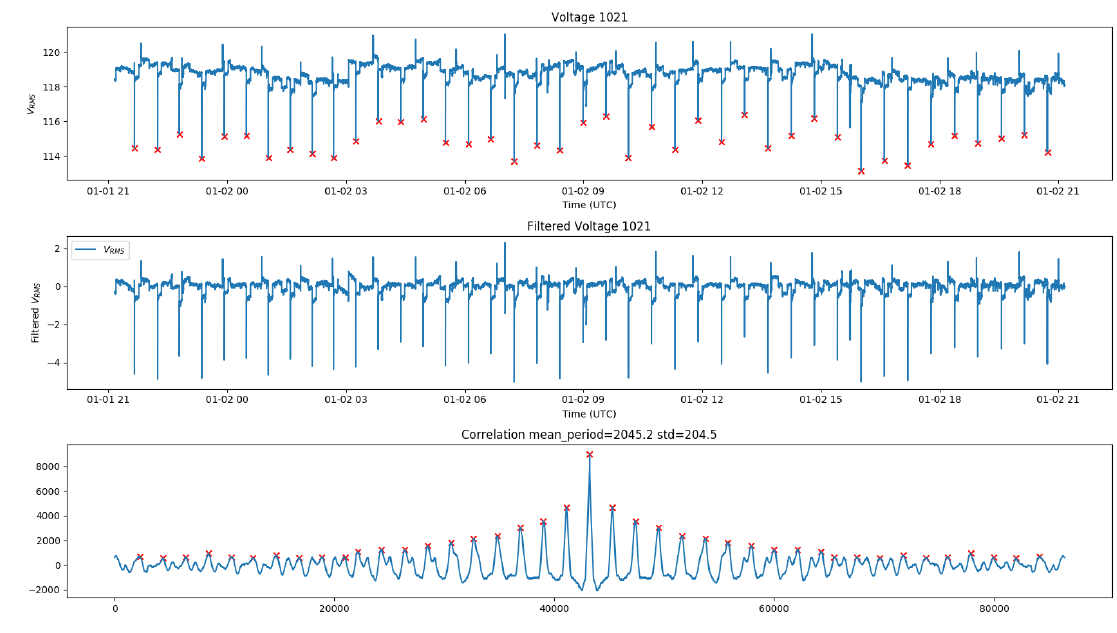
Figure 15. Detection of periodic voltage